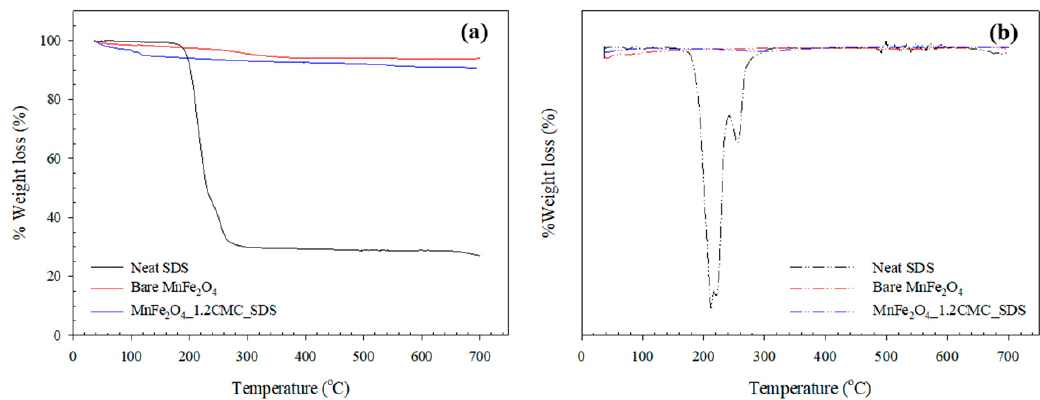
Figure 2. Thermograms of the neat SDS surfactant, bare MnFe 2 O 4 and MnFe 2 O 4 _1.2CMC_SDS ferrite nanoparticles: ( a ) TGA curve; and ( b ) DTG curve.